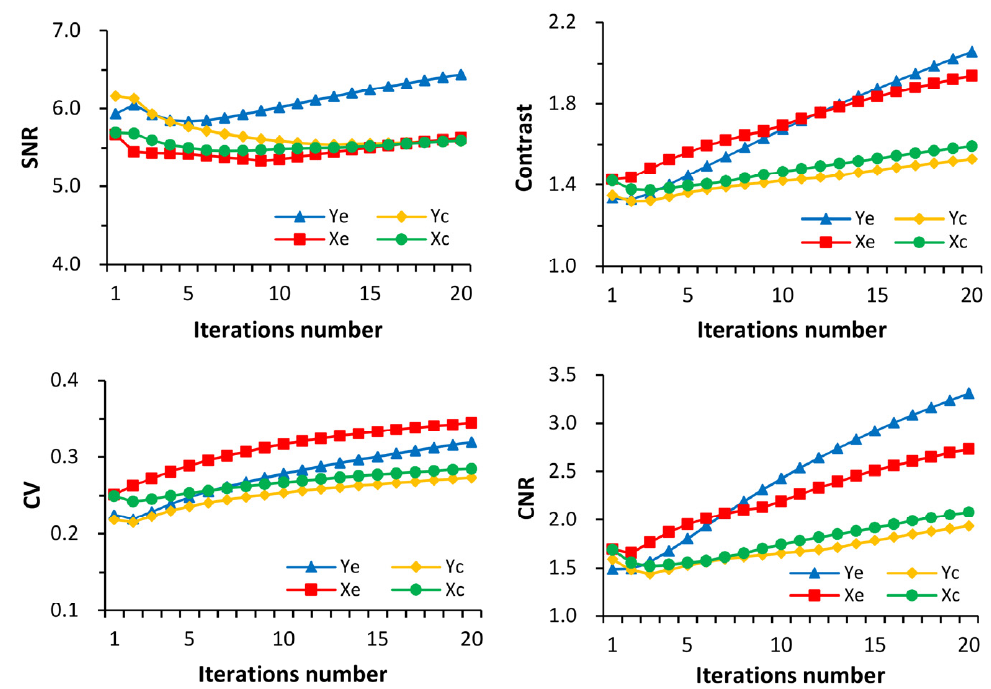
Figure 7. The SNR, contrast, CV, and CNR of PET images reconstructed by the 3D-OSEM algorithm (5 subsets, 20 iterations) in different orientations and positions are plotted as a function of the iteration number. Table 3. Time required for different iterative updates of the 3D-MLEM and 3D-OSEM (5 sub- sets) algorithms.